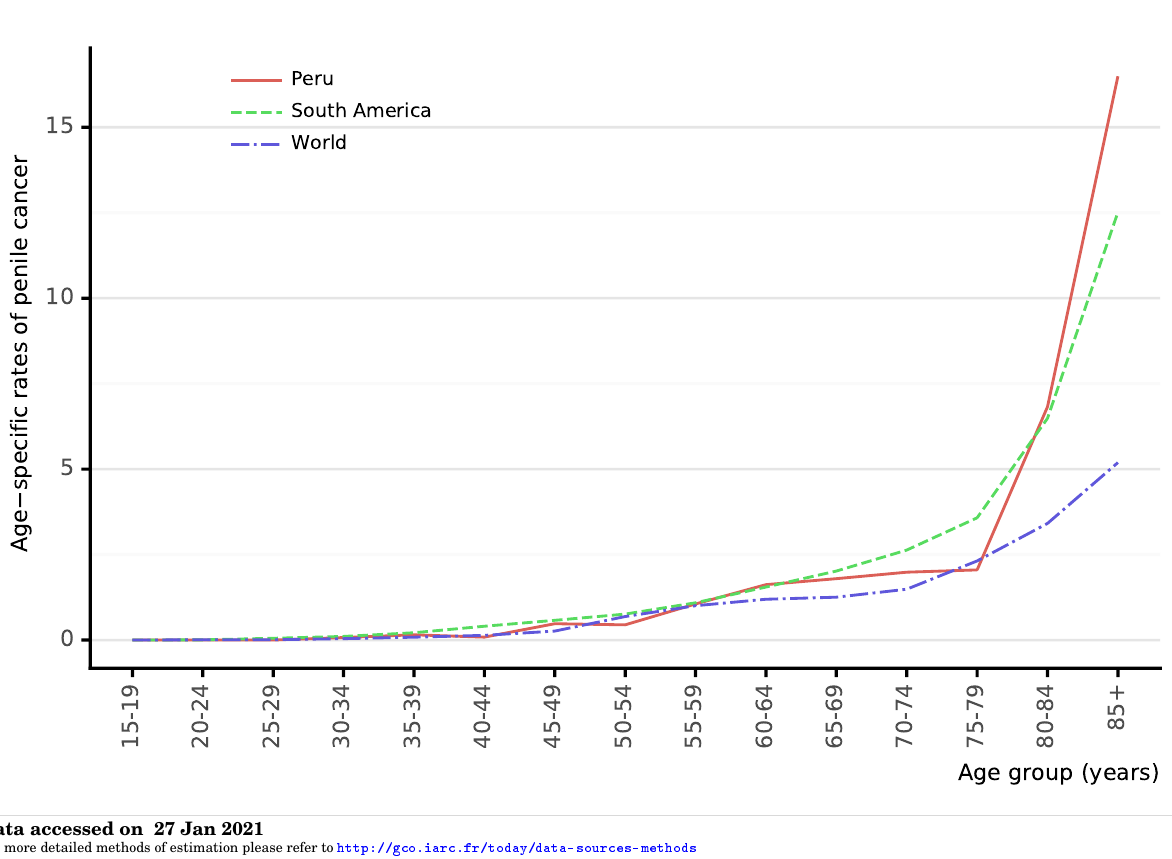
Figure 121: Comparison of age-specific penile cancer mortality rates in Peru, within the region, and the rest of